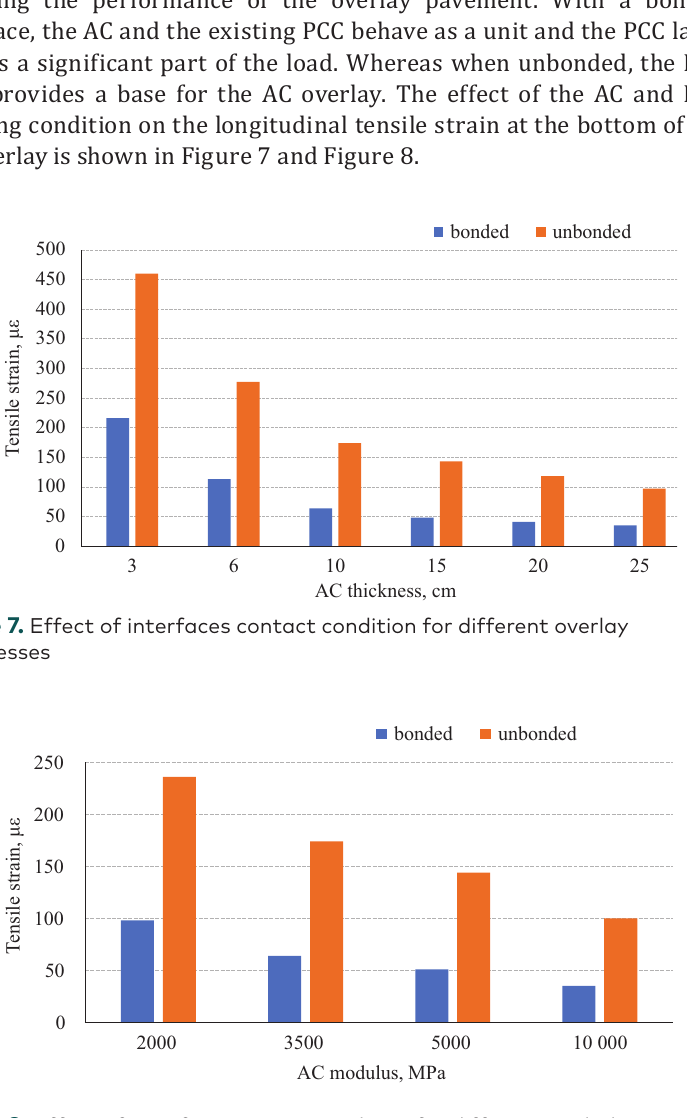
Figure 8. Effect of interface contact condition for different asphalt concrete